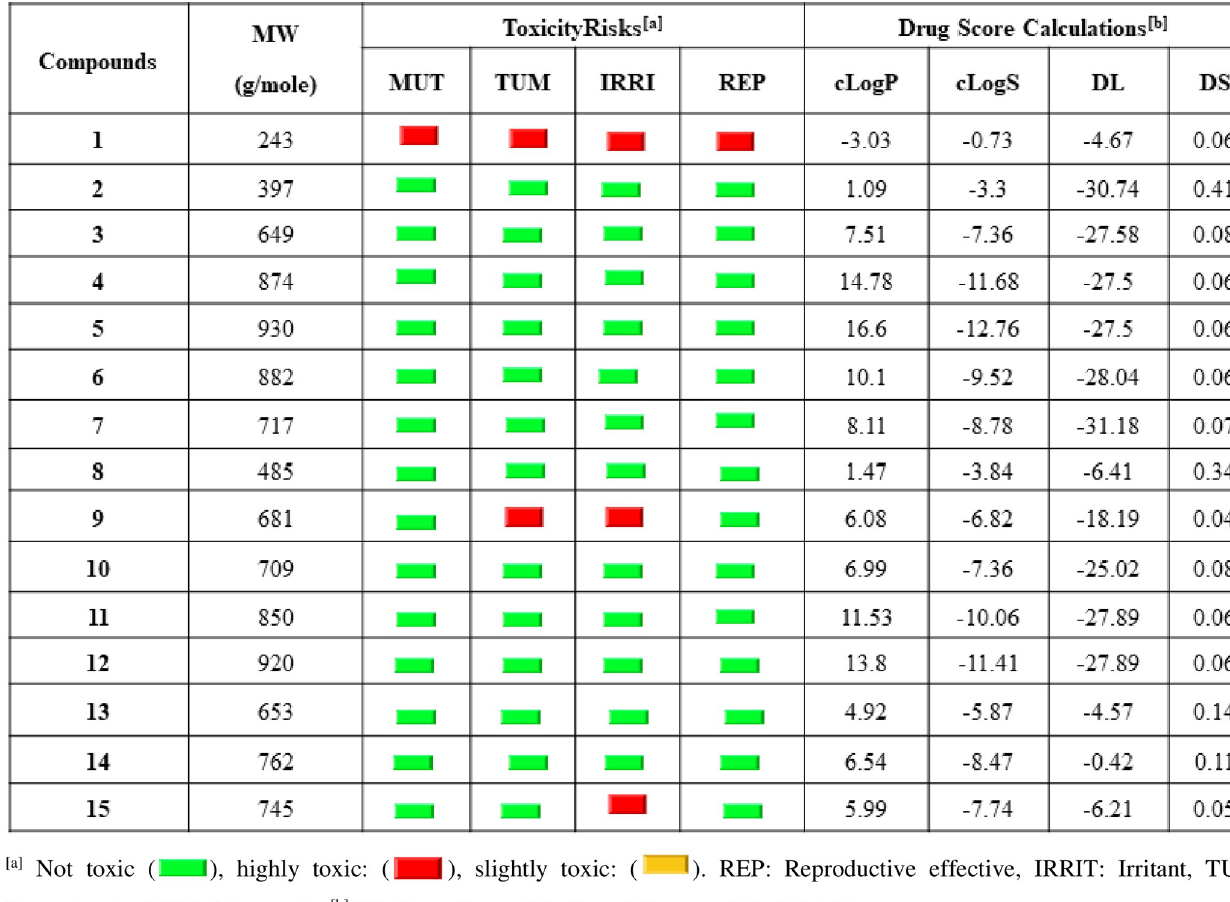
Fig 11. Comparison. Toxicity risks and drug score calculations of compounds 1–15 .